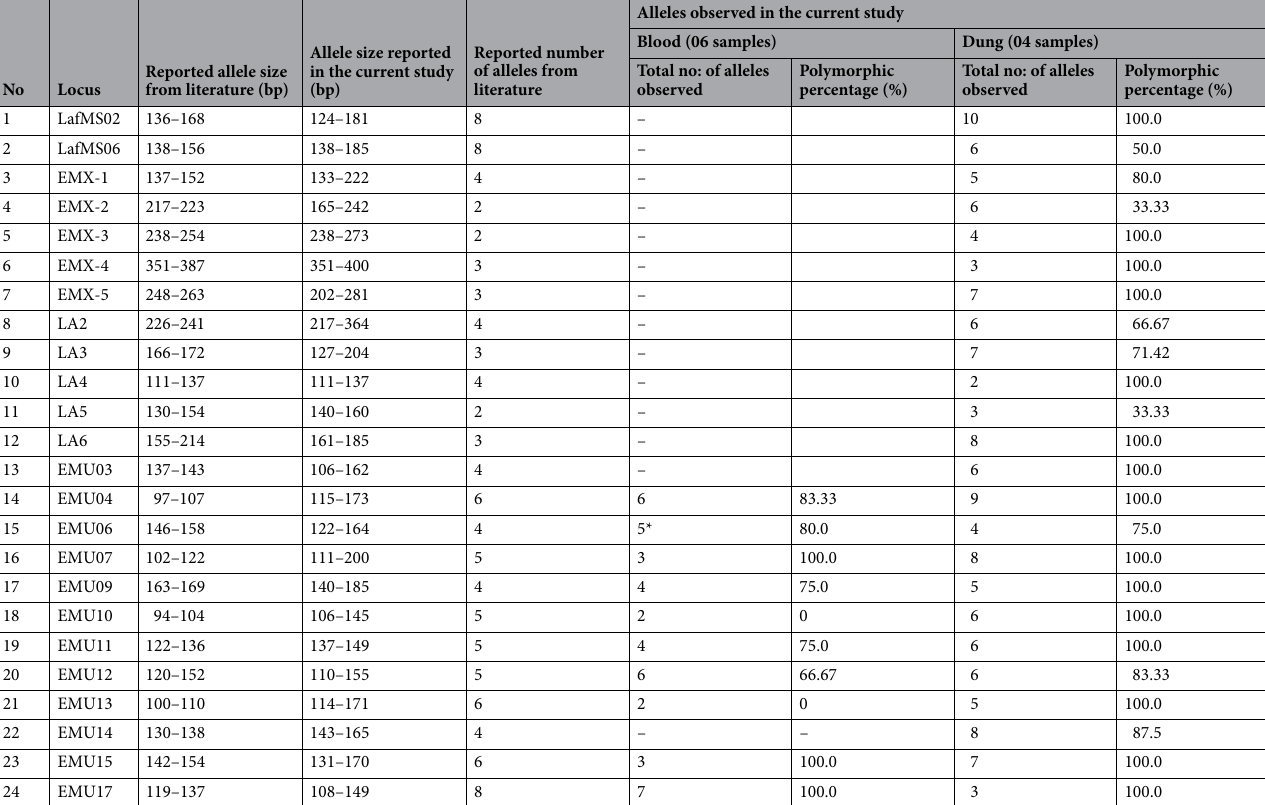
Table 1. Summary of capillary electrophoresis data. The blood and dung samples are not from the same elephants. However, monomorphic bands were present in all the cases. *For some loci only few samples amplified (3 out of 6). (–) Not tested in the current study.